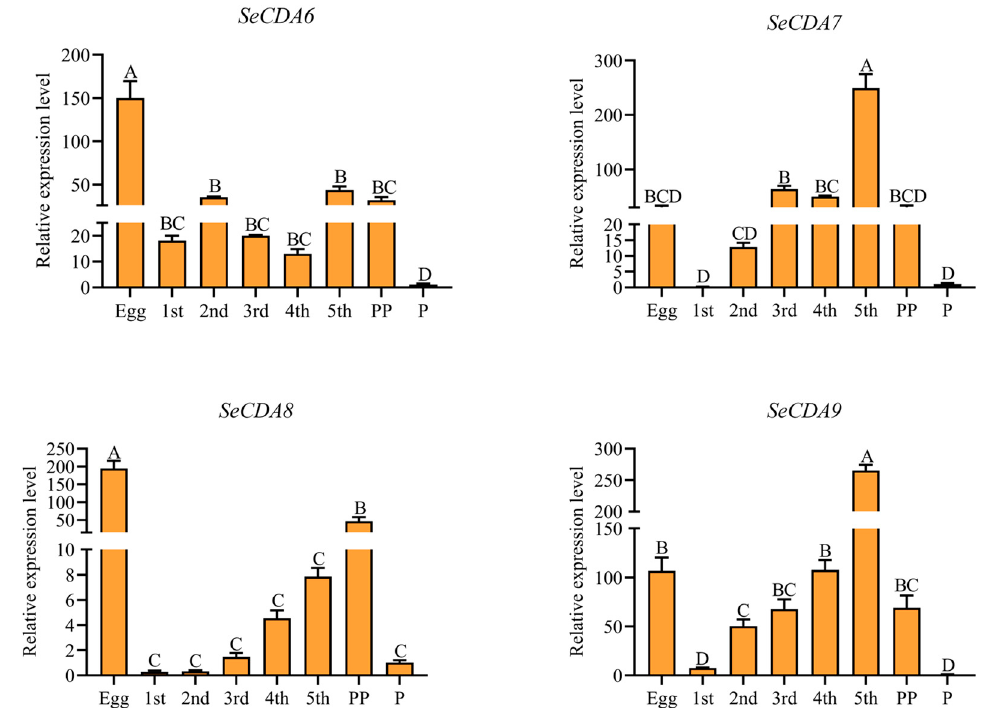
Figure 3. Expression profiles of SeCDAs in different developmental stages. Developmental stages include the egg, first-to-fifth-instar larvae, prepupae and pupae. Data were calibrated by using β -actin and presented as means ± SE of three separate experiments. The group of the pupae data was used for normalization. Different letters above the bars represent the different significances of the samples ( p < 0.01).